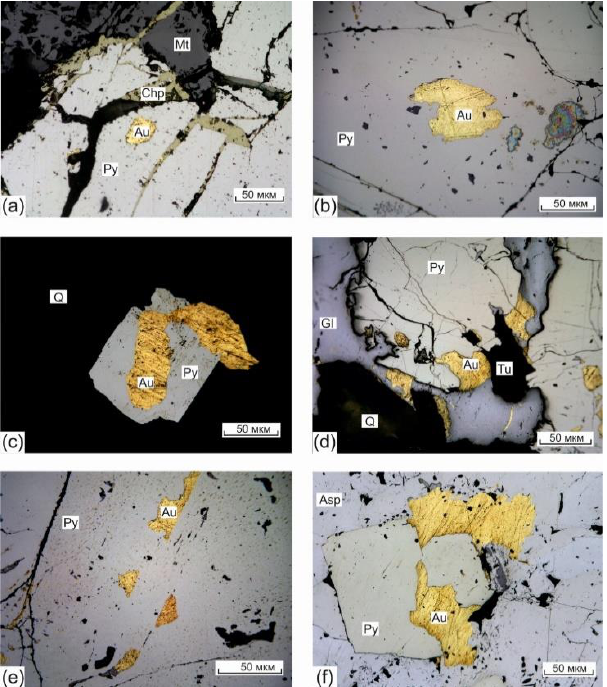
Figure 3. Intergrowths of pyrite and native gold in the ore of the gold deposits: ( a , b ) Talatui, ( c , d ) Teremkyn and ( e , f ) Darasun. Au, native gold; Py, pyrite; Asp, arsenopyrite; Chp, chalcopyrite; Mt, magnetite; Tu, tourmaline; Q, quartz.